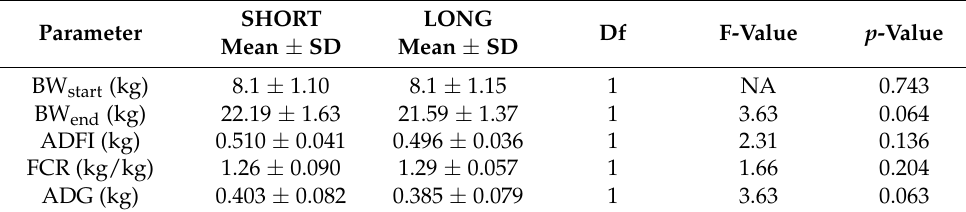
Table 1. Performance parameters of short photoperiod piglets (SHORT, 8 h light and 16 h dark) compared to long photoperiod piglets (LONG, 16 h light and 8 h dark). Mean values and their standard deviations are given for each parameter. The F-value of the starting weight was not determined. Therefore, no statistical analysis was made for this parameter (not available or NA).